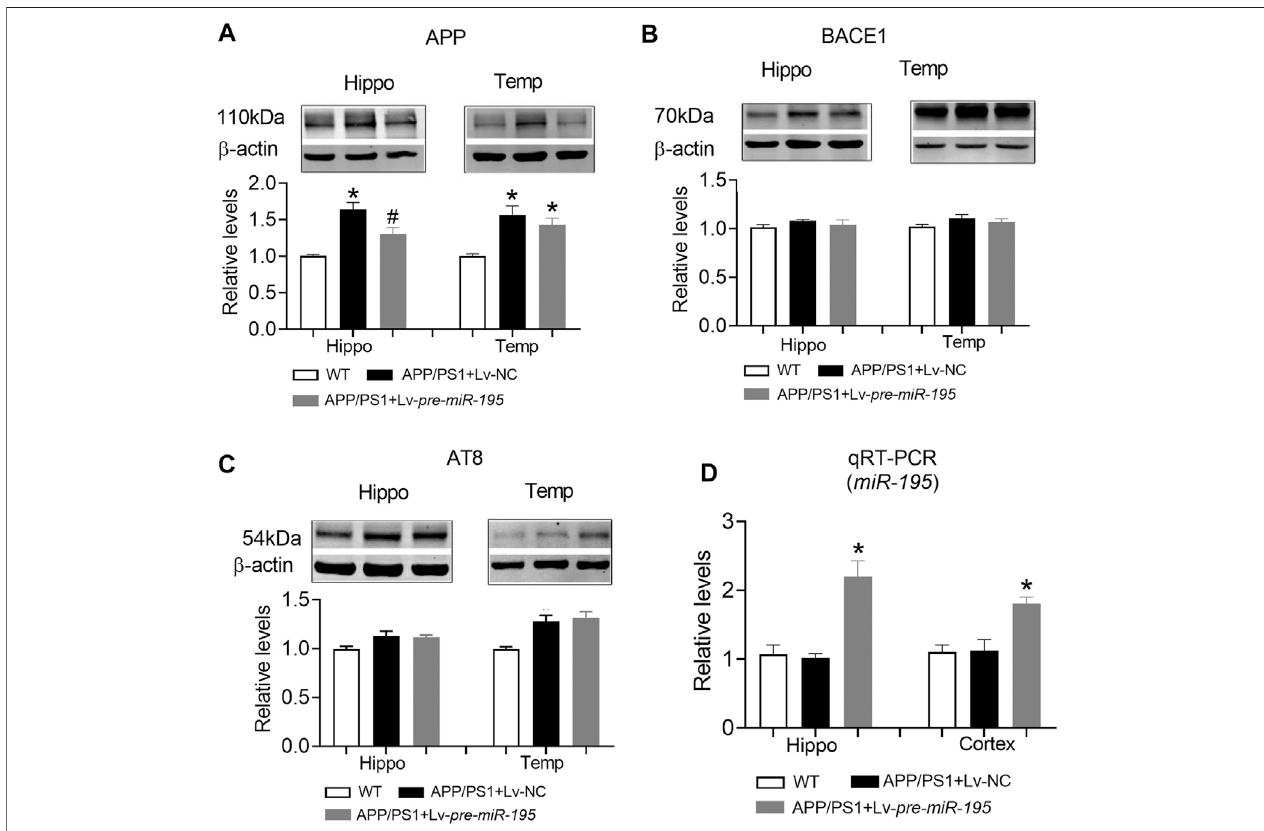
FIGURE 6 | The effect of miR-195 on the expression of APP, BACE-1, AT8 protein in the hippocampi of APP/PS1 mice after Lv-pre -miR-195 injection for 2M (A) MiR-195 down-regulated the expression of APP protein in hippocampus but did not affect it on temporal lobe cortex of APP/PS1 mice. * p < 0.05 vs. WT. # p < 0.05 vs. Lv-NC (B) There was no signi fi cant change in BACE-1 protein in hippocampus and temporal lobe of 6M-old APP/PS1 mice (C) MiR-195 doesn ’ t reverse the high expression of AT8 in the brain of 6M-old APP/PS1 mice. * p < 0.05 vs. WT (D) MiR-195 levels in the hippocampus and cortex of APP/PS1 mice after intracerebral injection of Lv-pre -miR-195 2M. * p < 0.05 vs. WT. n (cid:2)